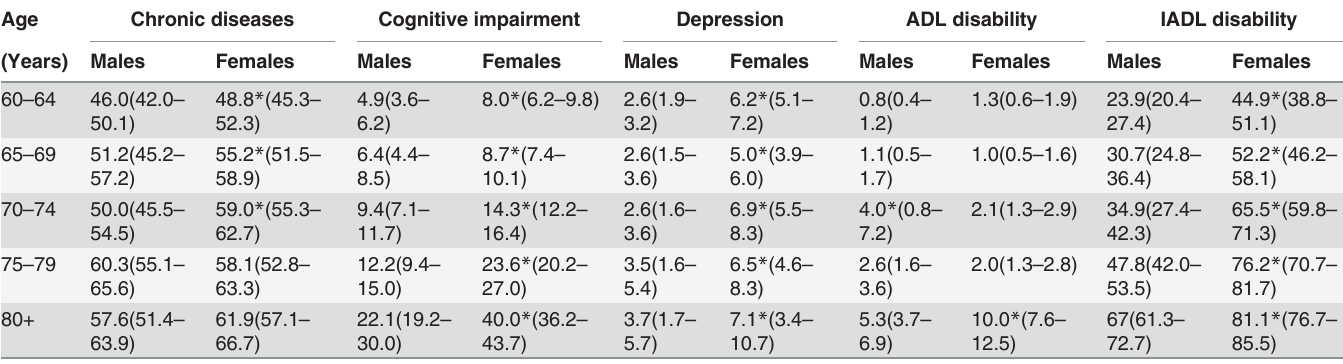
Table 2. Prevalence a (in percent) of morbidity and disability by age and genders in Thailand, 2009 (95% CIs in parentheses).